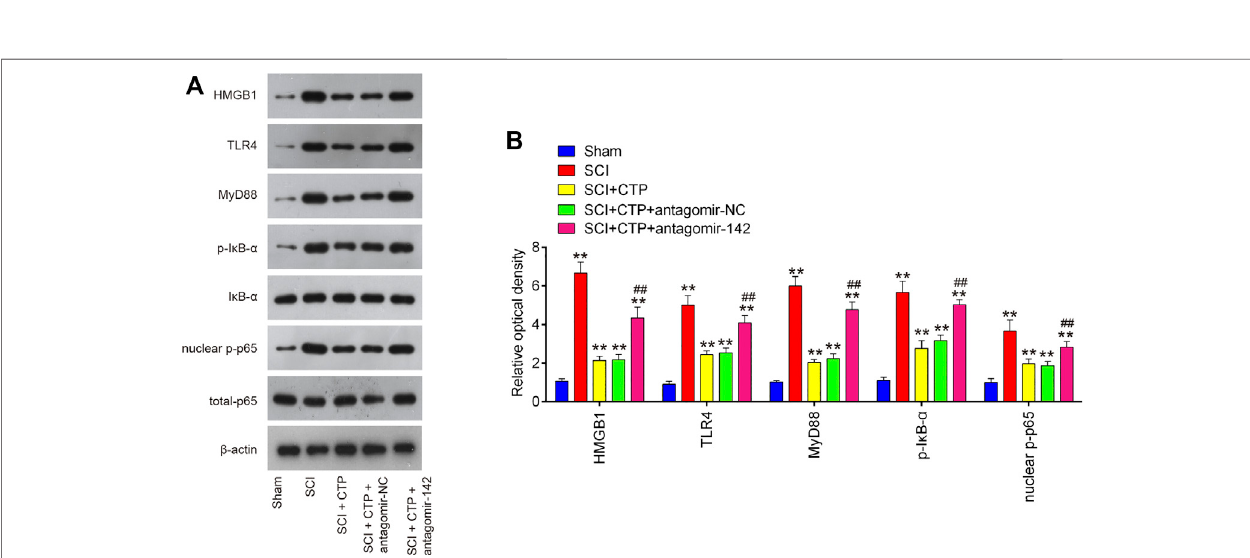
FIGURE 8 | CTP blocked the activation of HMGB1/TLR4/MyD88/NF- κ B signaling pathway via regulating miR-142. The mice were subjected to SCI and then treated with antagomiR-142/antagomir-NC via intrathecal injection starting 15 min after SCI. On the following day after SCI, CTP was treated to mice once a day for 4 weeks by gavage. (A) The protein expressions of TLR4, HMGB1, MyD88, p -I κ B- α and nuclear-p-p65 were detected by western blot. (B) Bands were semi- quantitativelyanalyzedusingImageJsoftware,andnormalizedto β -actin.Datarepresentthemean ± SDofthreeindependentexperiments.* p < 0.05,** p < 0.01vs. Sham group; ## p < 0.01 vs. SCI + CTP